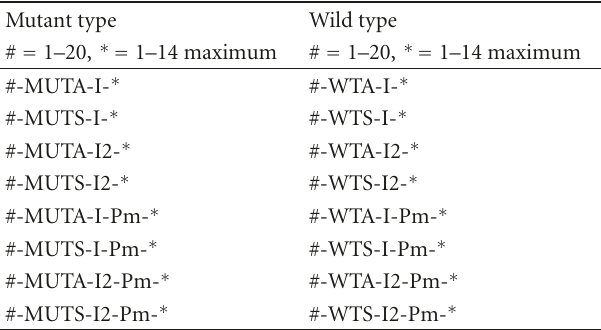
Table 3: The list of the mutations used in the microarray for getting the data for the performance